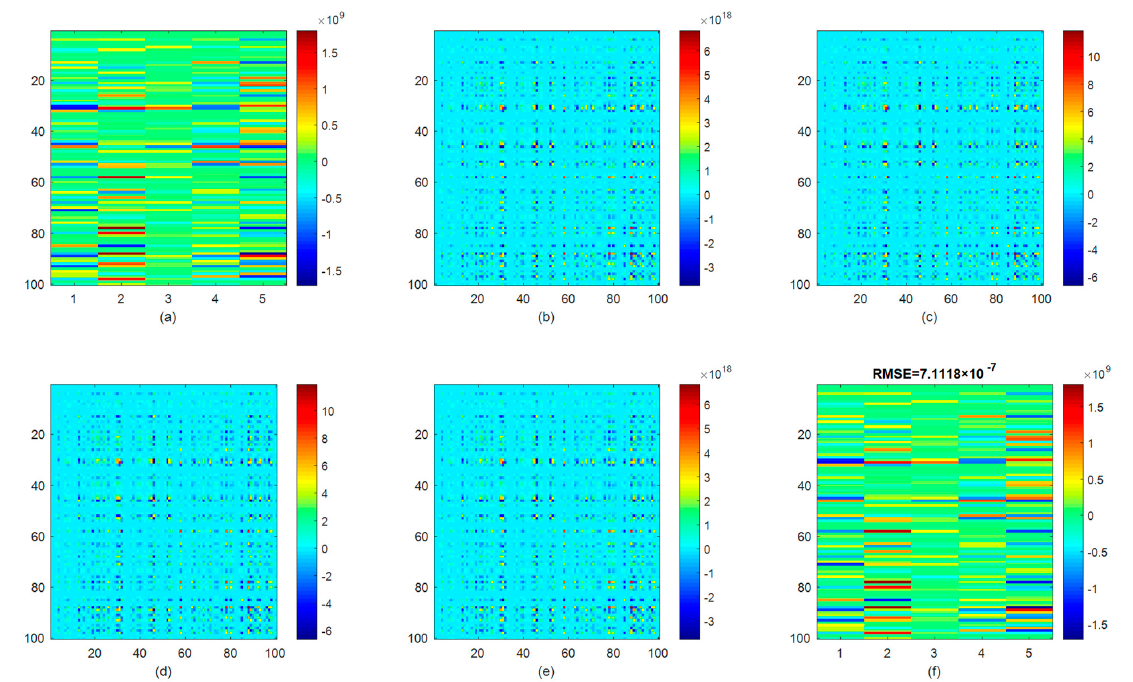
Figure 3. Illustrations of the effects of the proposed weights encoding/decoding and the normaliza- tion/denormalization method on training weights: ( a ) Analytically determined weights with the RLS method W 1,10 ( 4 ) ; ( b ) encoded weights with transpose matrix for unifying dimensions with other